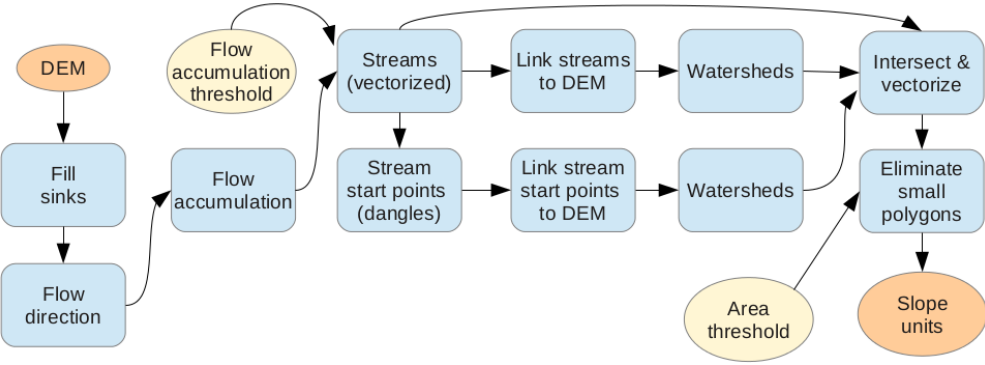
Figure 3. Workflow for the derivation of slope